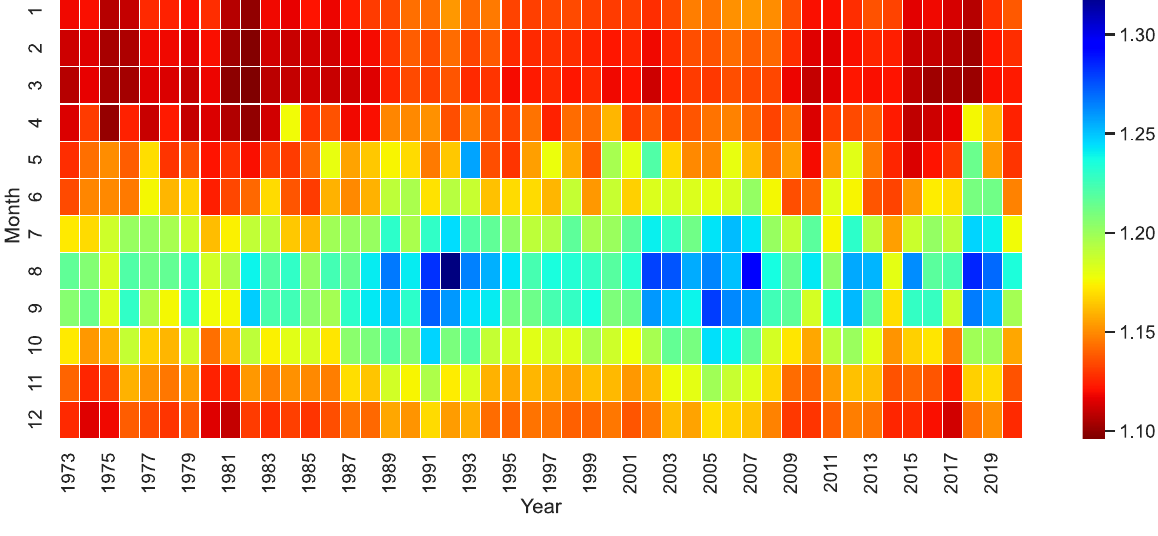
fig. 12. Distribution of the mean value of the safety coefficient in a given month for a multipleyear period based on the selected slopes in the western part of the Nałęczów Plateau [chart generated using Matplotlib (Hunter 2007) and seaborn (Waskom 2021) libraries in Python].